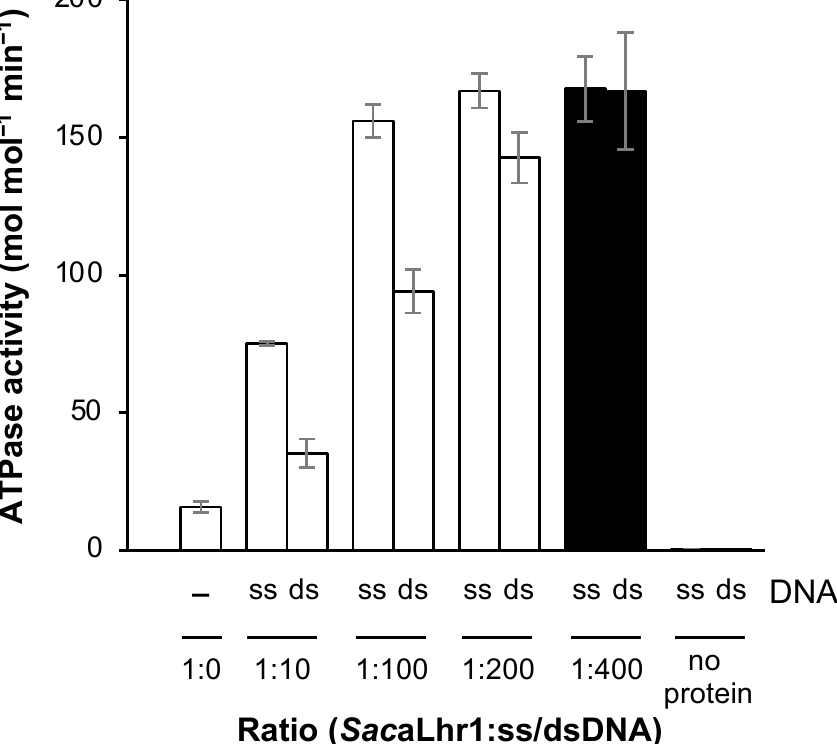
Figure 2. ss/dsDNA-dependent ATPase activity of Sac aLhr1. ATP activity refers to the amount of released Pi (mol) by a constant amount of the Sac aLhr1 (1 mol as a monomer) for a 1-min incubation under each reaction condition in the absence ( − ) or presence of ssDNA or dsDNA at a ratio of Sac aLhr1:ss/dsDNA = 1:0–400 and 0:400. One at the ratio means 2.25 pmol. Reactions carried out without Sac aLhr1, in the presence of 900 pmol ss/dsDNA (indicated as no protein) were considered as the negative control. Data are presented as mean ± standard deviation (SD), calculated from val- ues of three independent experiments.